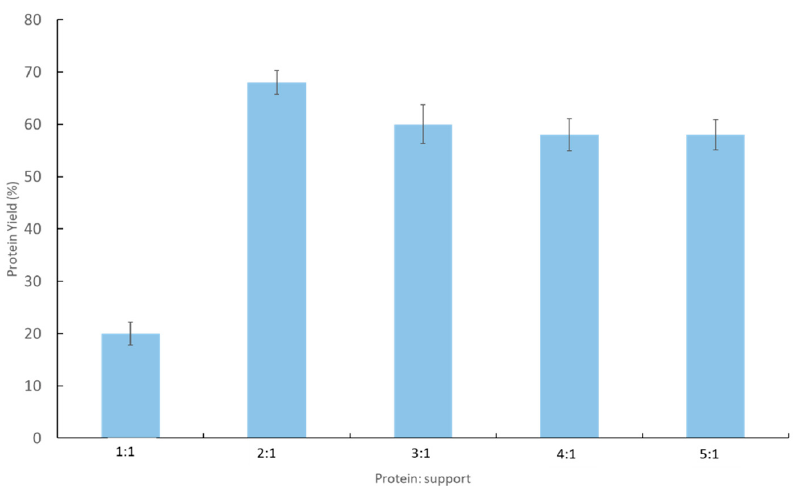
Figure 2. Effect of sample loading on immobilization.